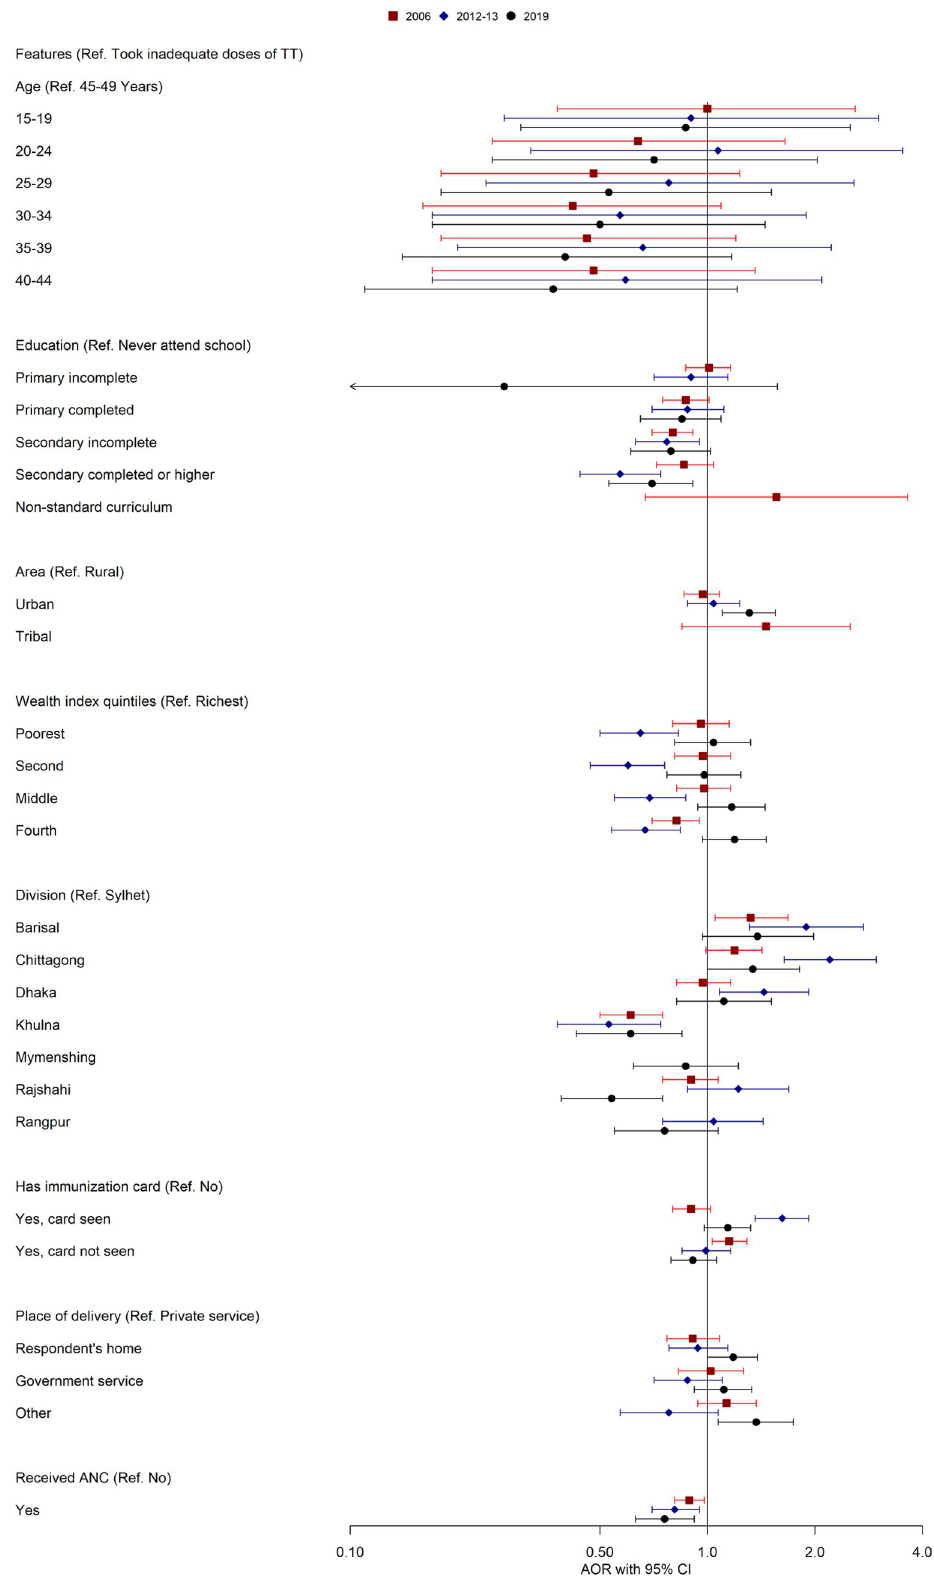
Fig 5. Determinants of taking adequate tetanus toxoid vaccine in Bangladesh (2006–2019). https://doi.org/10.1371/journal.pone.0276417.g005 PLOS ONE | https://doi.org/10.1371/journal.pone.0276417 October 20,